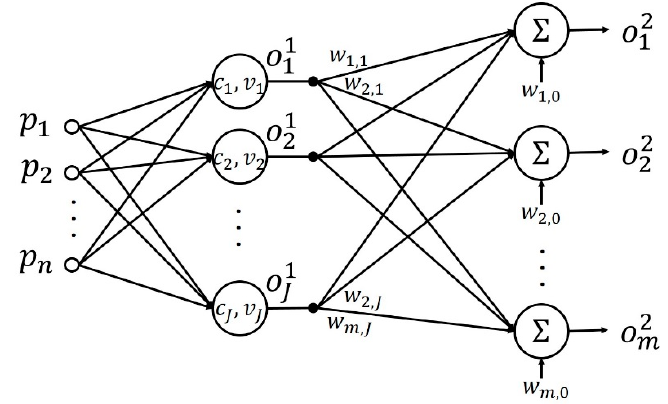
Figure 2. Diagram of single-label (SL)-Scheme for single-label classification.